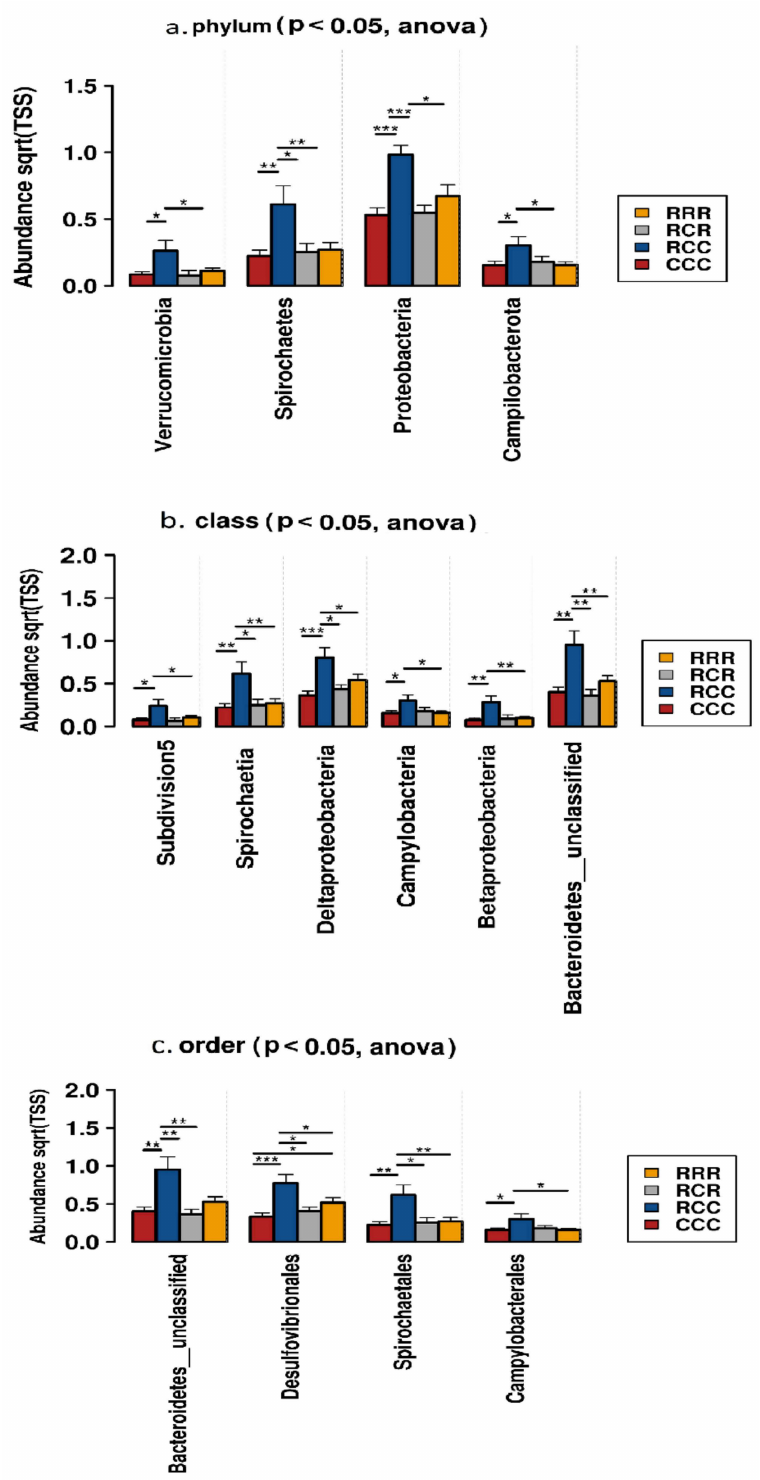
Figure 7. The distribution of significant bacterial taxa at ( a ) phylum; ( b ) class; and ( c ) order level in fecal samples of post weaning piglets fed different diets. RRR = sow RAC feeding-piglets RAC creep feeding-piglets post-weaning RAC feeding: RCR = sow RAC feeding-piglets control creep feeding- piglets post-weaning RAC feeding: RCC = sow RAC feeding-piglets control creep feeding-piglets post-weaning control feeding: and CCC = sow control feeding-piglets control creep feeding-piglets post-weaning control feeding. * p < 0.05, ** p < 0.01, *** p <